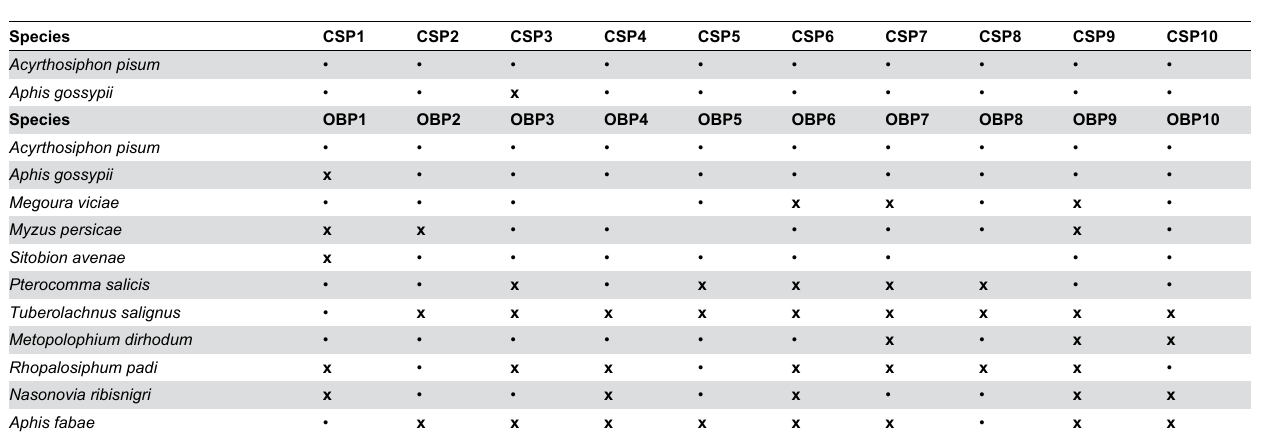
Table 2. RT-PCR of OBPs and CSPs in A. gossypii using A. pisum gene-specific